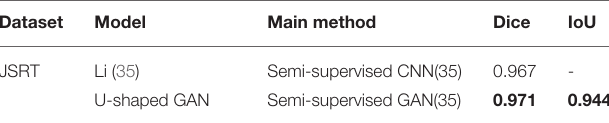
TABLE 1 | Comparison of U-shaped generative adversarial network (GAN) with the state-of-the-art semi-supervised